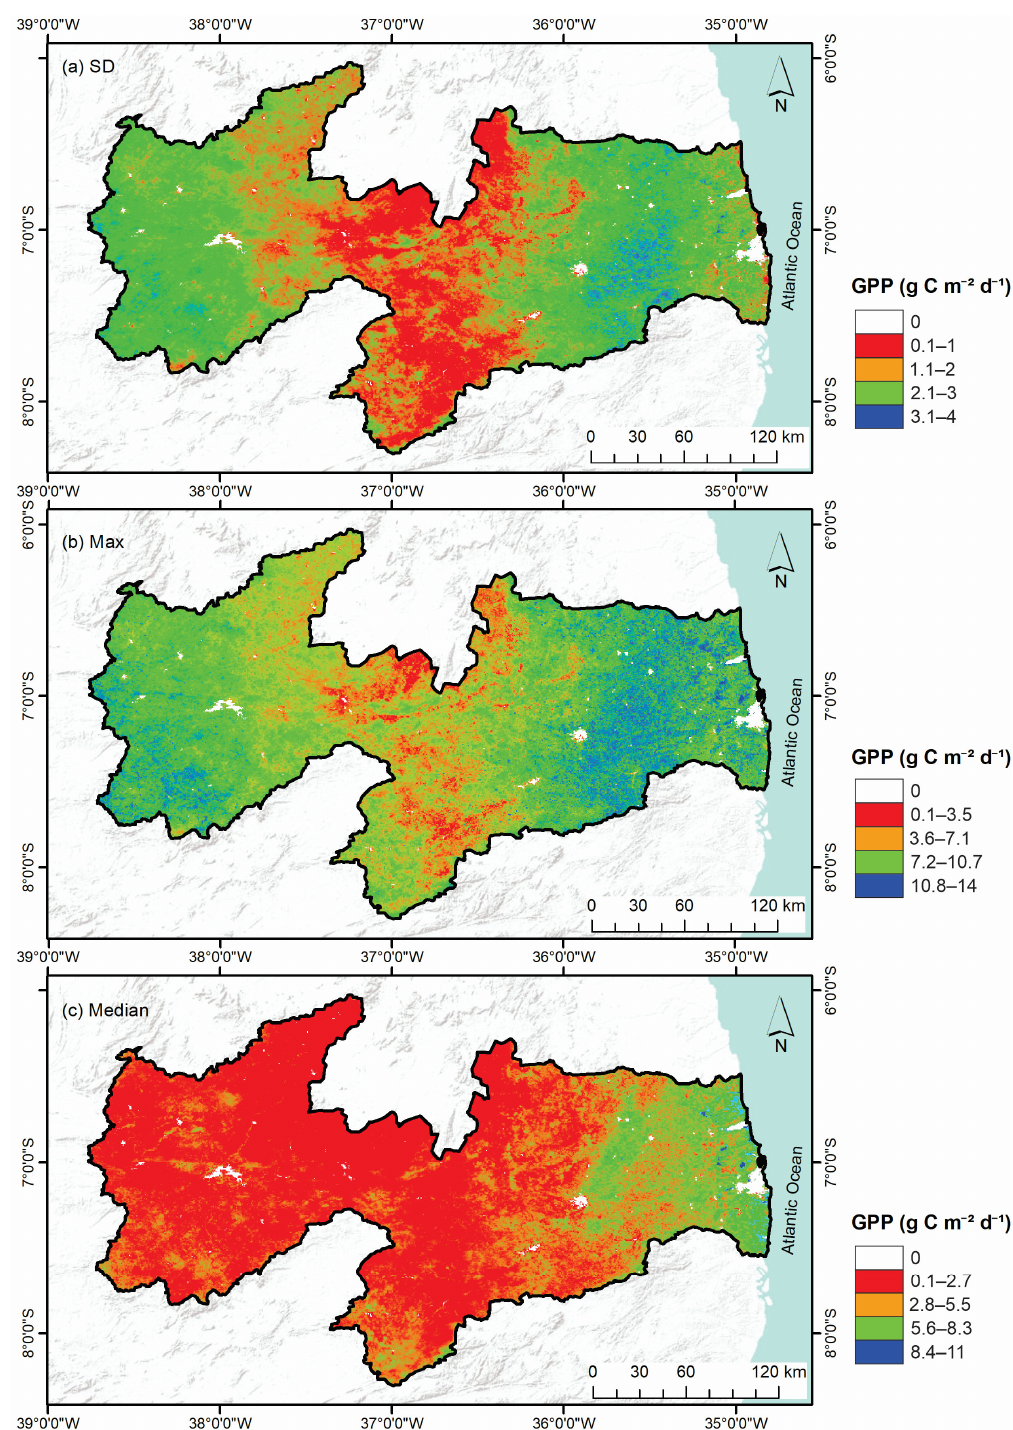
Figure 7. Statistical analysis (Standard Deviation–SD, Maximum–max, and median) of GPP for the state of Para í ba in 2013 derived from the product